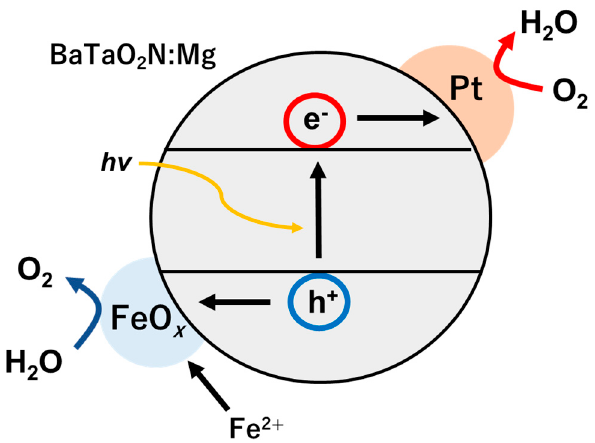
Figure 3. Secondary electron ( a , d ) and backscattered electron ( b , c , e , f ) SEM images of ( a – c ) Pt/BaTaO 2 N:Mg and ( d – f ) FeO x /Pt/BaTaO 2 N: Mg. The loading amounts of Pt and FeO x are 0.5 and 0.4 wt%, respectively. The scale bar is 100 nm.